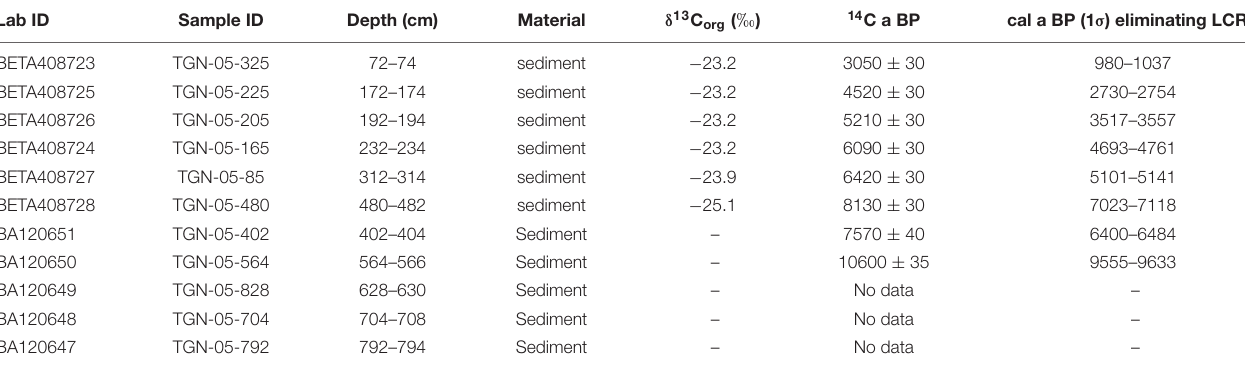
TABLE 1 | Radiocarbon dating results for section TGN-05 determined in the BETA 14 C Lab (BETA) and Beijing University 14 C Lab (BA). Lab